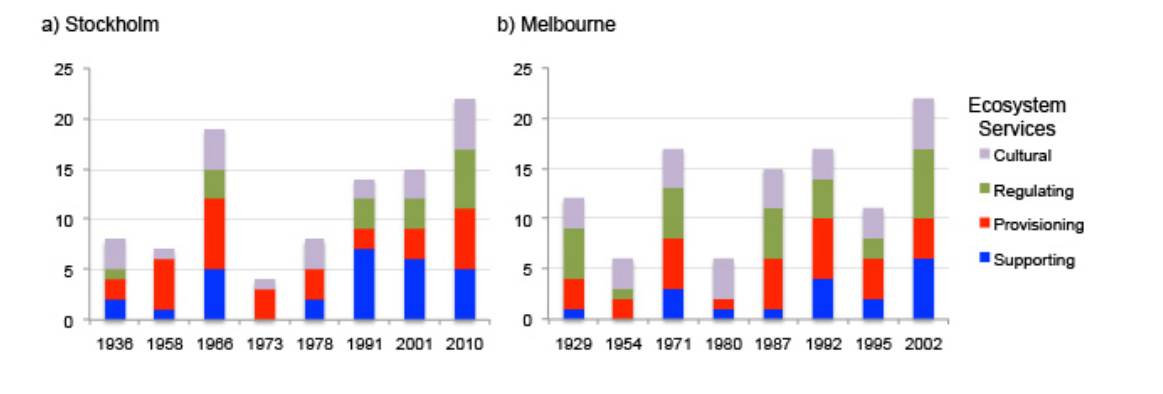
Fig. 1 . Total number of ecosystem services addressed by category over time for Stockholm (a) and Melbourne